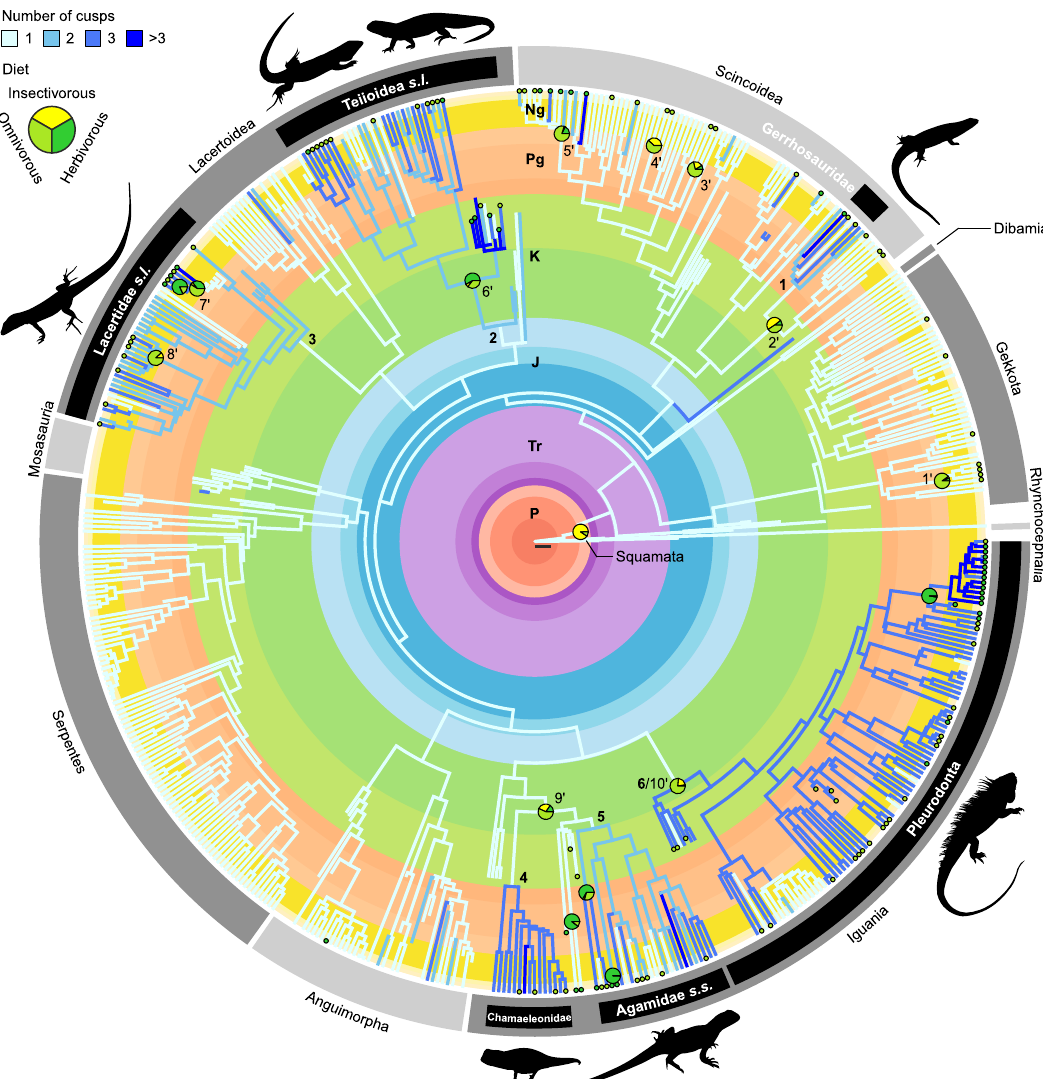
Fig. 2 Multiple independent acquisitions of multicuspid teeth and plant consumption are found across squamate phylogeny. Known and maximum likelihood ancestral state reconstructions of the number of cusps (branch colours) and diet (node pie charts and branch tip small circles) in squamates. Pie charts indicate the most ancient nodes with >50% combined relative likelihood for omnivorous and herbivorous diets; also shown are the fi rst nodes with >50% relative likelihood for herbivory within already omnivorous clades. Branch tip circles indicate omnivorous/herbivorous species. Six major clades show independent originations of multicuspid teeth: 1: Gerrhosauridae (node 616; see Supplementary Fig. 1). 2: Teiioidea + Polyglyphanodontia